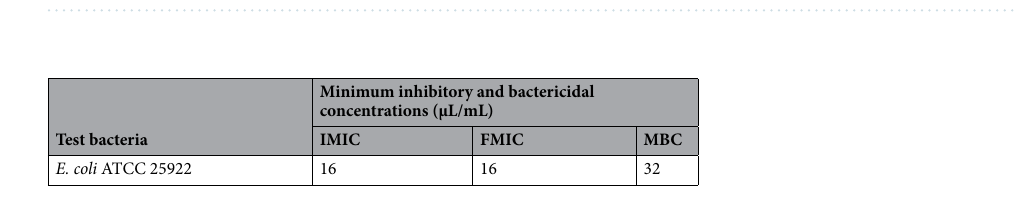
Table 1. Effect of compounds from natural products against selected bacterial pathogens. *Includes 5 mm well size.